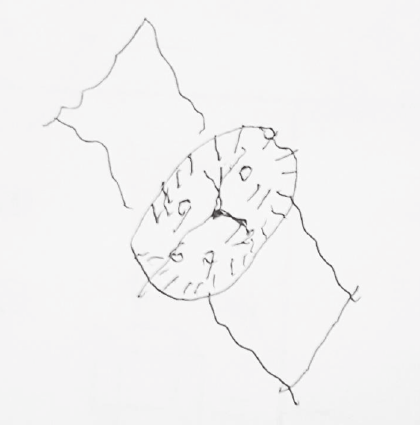
Figure 3: Patient’s drawing of a watch at “ten past eleven,” part of MOCA test administered. Patient scored 6/30, with severe deficien- cies in visuospatial/executive function, attention, and delayed